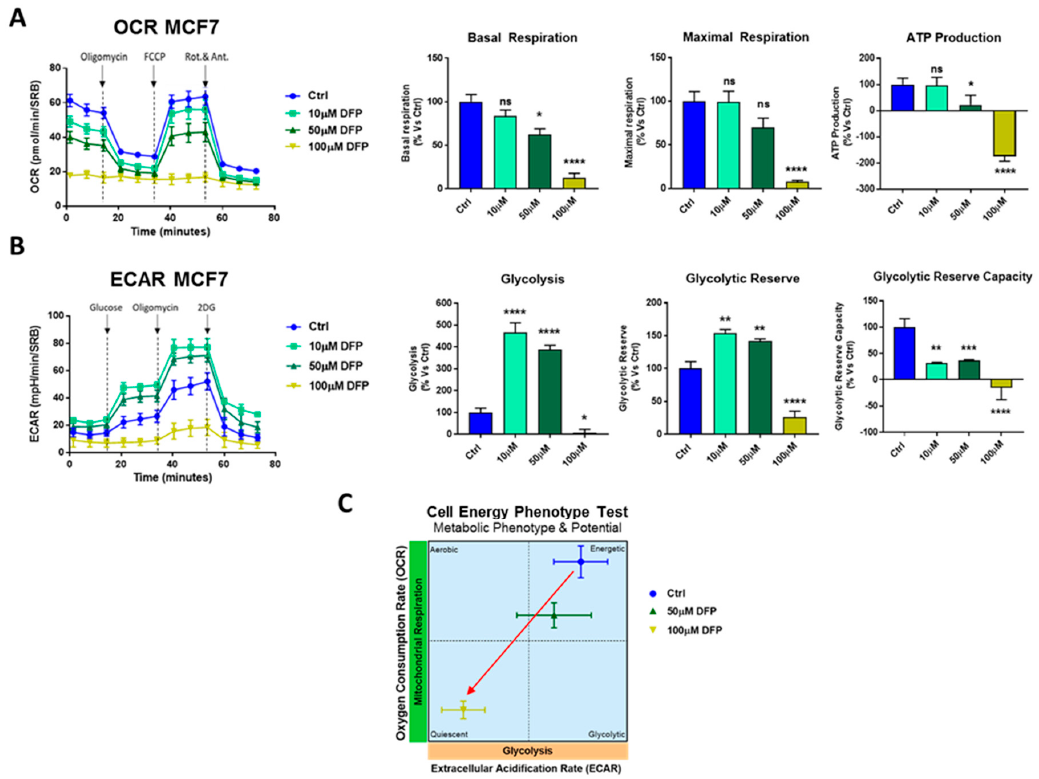
Figure 5. DFP reduces the OCR and extracellular acidification rates (ECAR) in MCF7 cells: 120 h of treatment (5 days). ( A ) Note that DFP dose dependently inhibited OCR, with maximal e ff ects at 100 µ M, resulting in severe ATP depletion. Significantly, basal respiration reduction and ATP depletion were also observed at 50 µ M. ns = not significant; * p < 0.01; ** p < 0.001; **** p < 0.00001. ( B ) Note that DFP dose dependently inhibited ECAR, with maximal e ff ects at 100 µ M, resulting in the near complete inhibition of glycolysis. ns = not significant; * p < 0.01; ** p < 0.001; *** p < 0.0001; **** p < 0.00001. ( C ) OCR vs ECAR metabolic phenotype and potential is represented by following the manufacturer’s guidelines and instructions (Seahorse, Agilent Technologies). The energy plot shows that the 100 µ M DFP-treated cells are clearly metabolic quiescent compared with the vehicle alone-treated